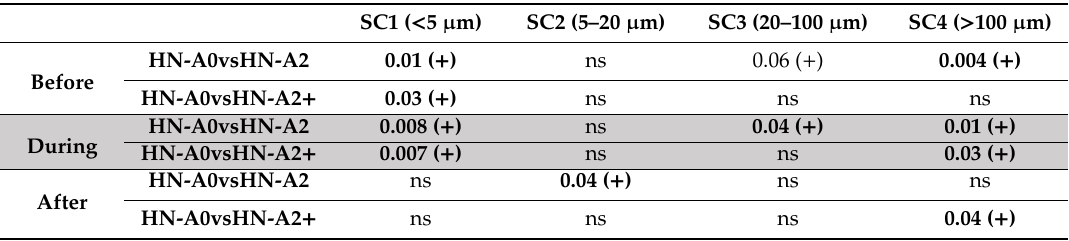
Table 3. p values of size class (SC) LMMs within HN (bold values indicate p < 0.05, heat wave period (during) is